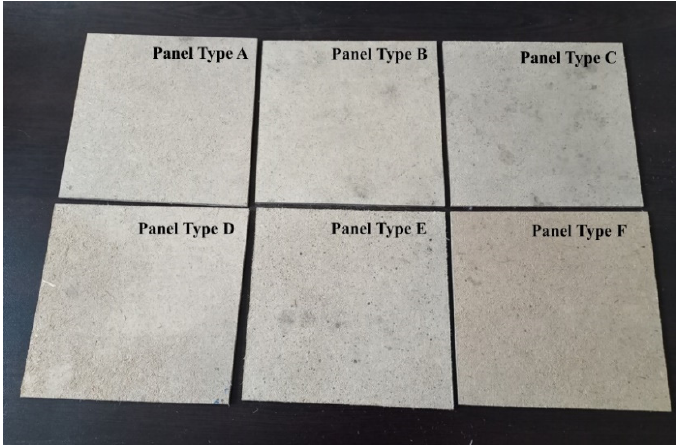
Figure 2. Fiberboard panels bonded with HL and PF resin: Type A—10% of binders, from which 10% was PF resin; Type B—10% of binders, from which 20% was PF resin; Type C—10% of binders, from which 30% was PF resin; Type D—12% of binders, from which 10% was PF resin; Type E—12% of binders, from which 20% was PF resin; Type F—12% of binders, from which 30% was PF resin.